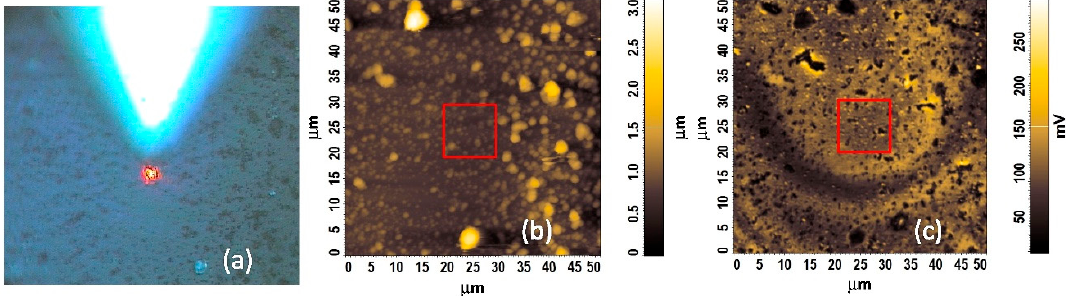
Figure 5. Surface analysis of the Nafion ® -based fiber optic sensing microstructure; ( a ) optical micrograph with AFM tip position and laser (633 nm) spot ( b ) 50 µ m × 50 µ m AFM height topography micrograph with AFM tip position and laser (633 nm) spot ( b ) 50 µm × 50 µm AFM height topography image, ( c ) 50 µ m × 50 µ m CLSM image, ( c ) 50 µm × 50 µm CLSM image.